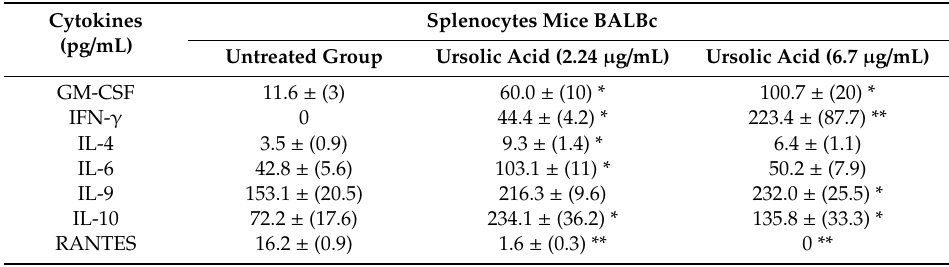
Table 5. Quantification of cytokine production of splenocytes untreated and treated with UA tested at the IC 50 concentration corresponding to L. amazonensis and L. infantum.